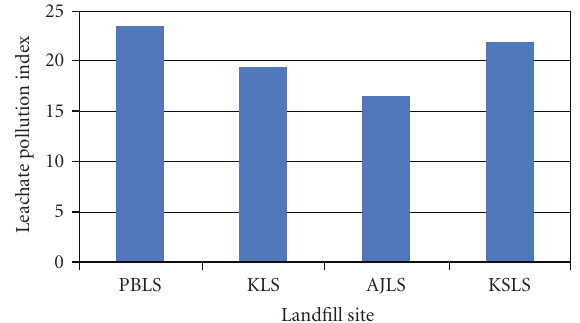
Figure 1: Leachate pollution index for four landfill sites.